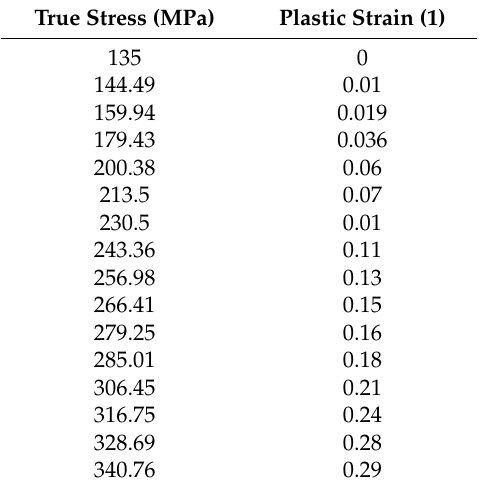
Table 2. True stress and plastic